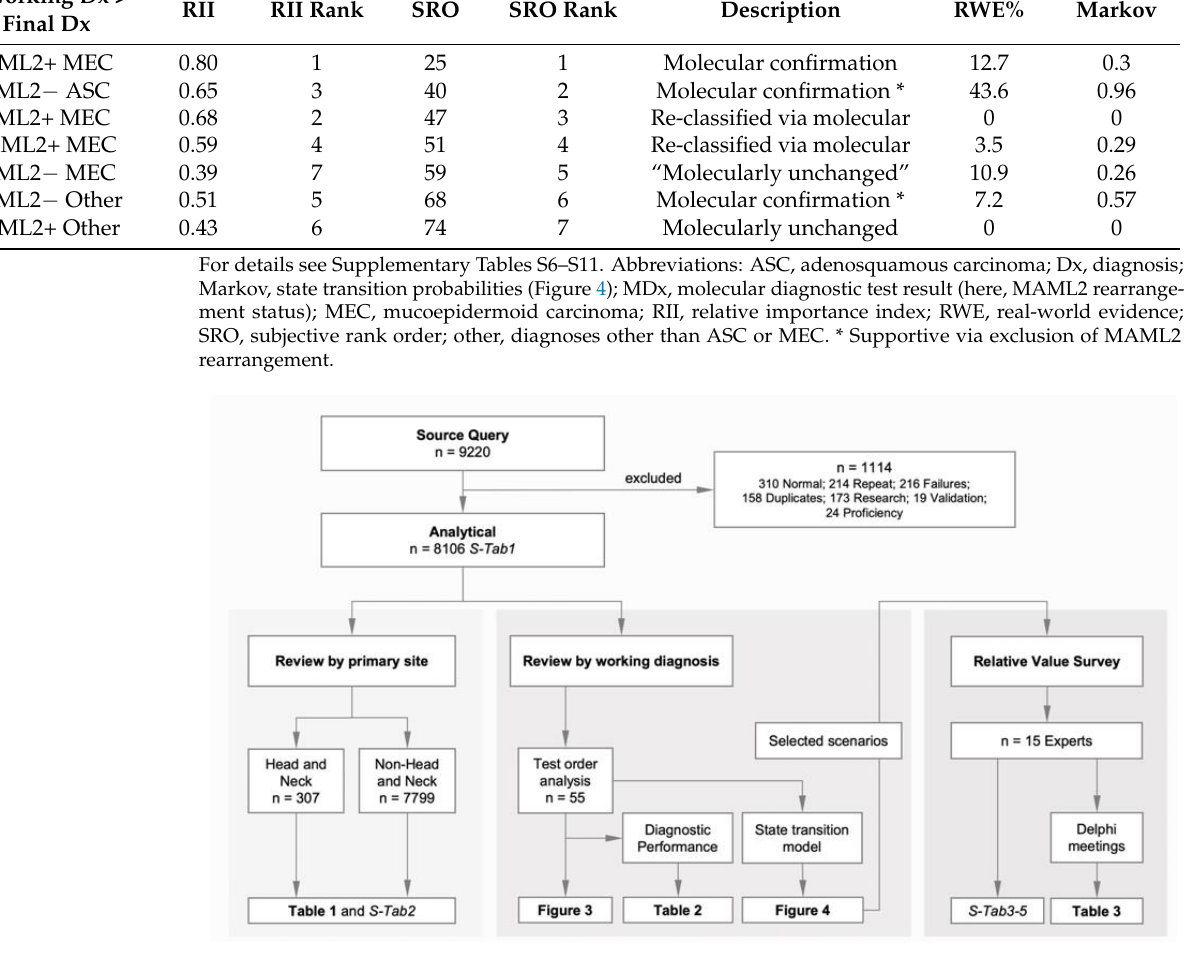
Figure 4. Summary of data acquisition. After data clean-up, the analytical cohort was divided into 2 cohorts (review by primary site and review by working diagnosis).